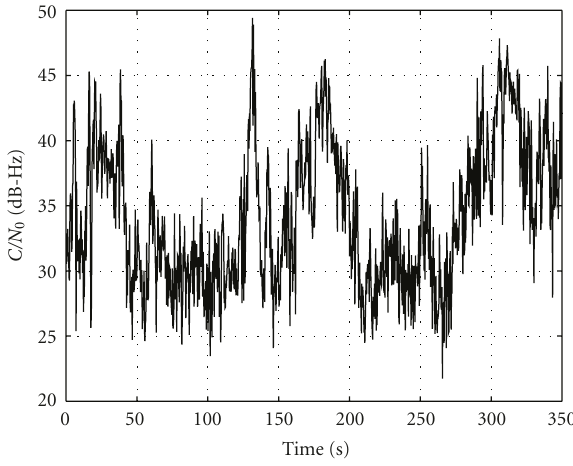
Figure 3: Variation of C/N 0 during the scenario.